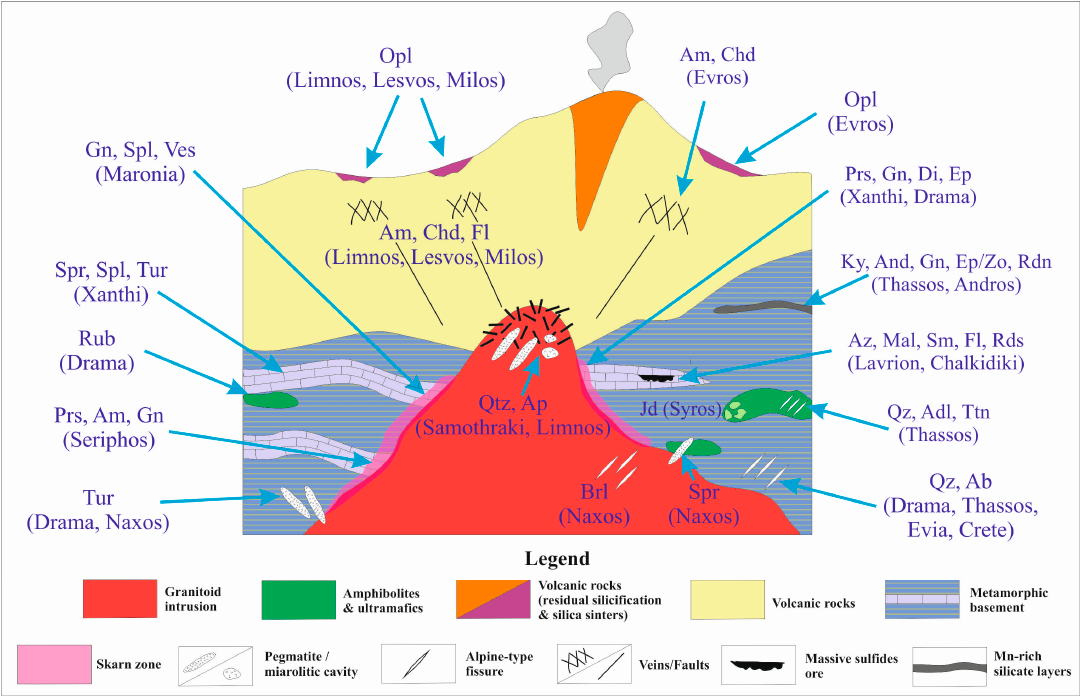
Figure 13. Hypothetical model presenting the various environments related to crystallization of